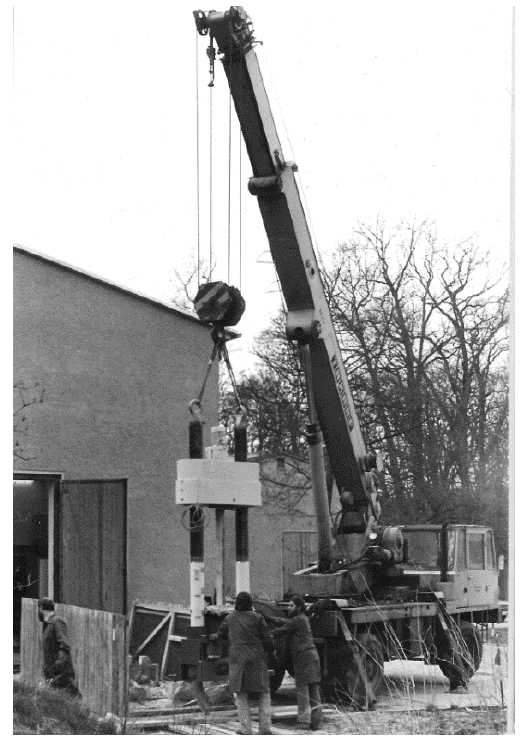
Figure 3. Assembling the triaxial press.